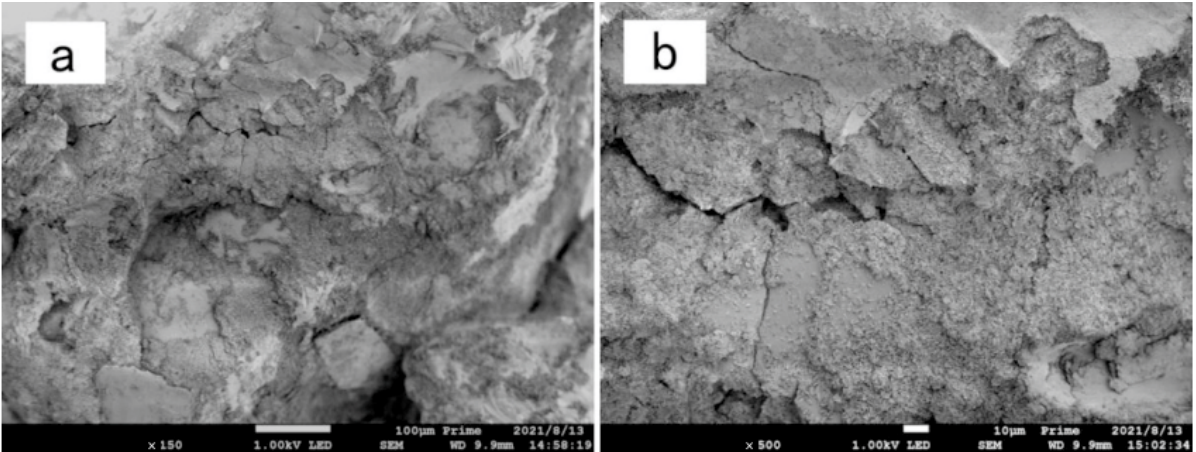
Figure 14. Electron microscope image of sample with 12%PVA + 12% active magnesium oxide content. ( a ) 150-fold magnified ( b ) 500-fold magnified